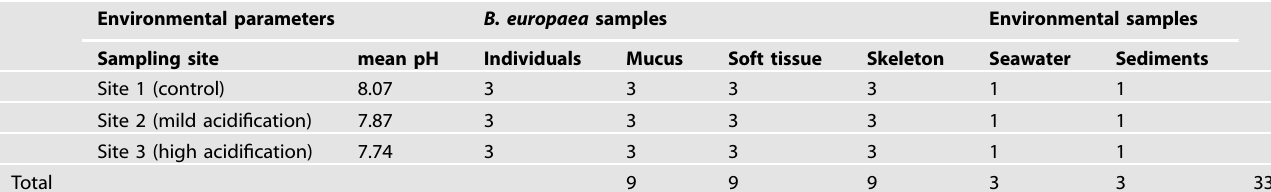
Table 1. Summary of B. europaea and environmental samples, and features of the sampling sites. Environmental